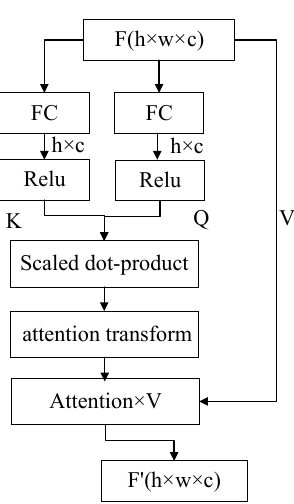
Figure 4. Channel attention based on a scaled dot-product module.